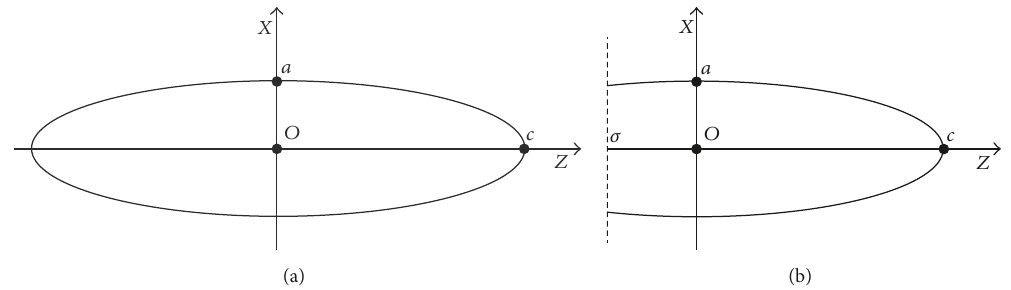
Figure 1: Ellipse centered in the origin and axle shafts 𝑎 and 𝑐 , in (a). In (b), truncated ellipse by the line 𝑧 = 𝜎